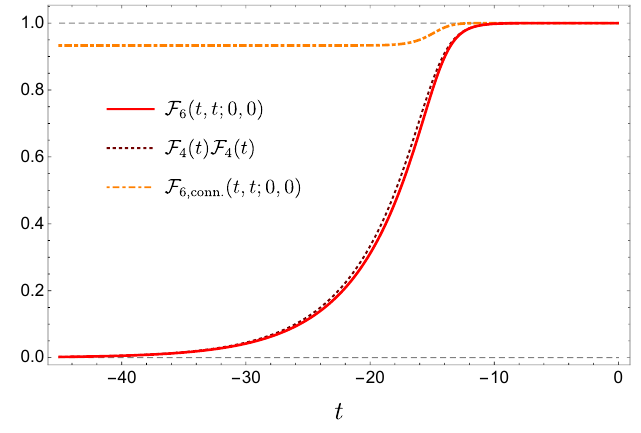
Figure 6 . Illustration of the result (3.7) for t 1 = t 2 ≡ t . Because the ‘connected’ contribution saturates to an O (1) floor value, it only changes the full six-point function by a very small amount. The transition happens when both − t G/ (2 sin δ 1 , 2 ) = 10 − 6 (such that t ∗ ≈ 13 . 8